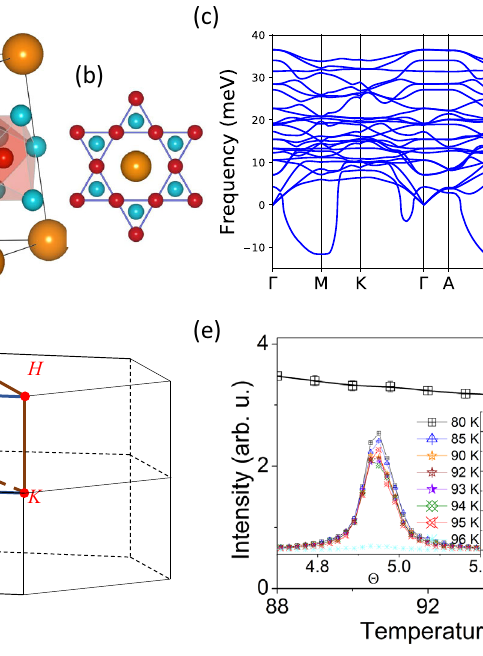
The red ellipse marks the region where phonons are measured in Fig. 4d. d Sketch of the Brillouin zone along the main symmetry directions. e Temperature